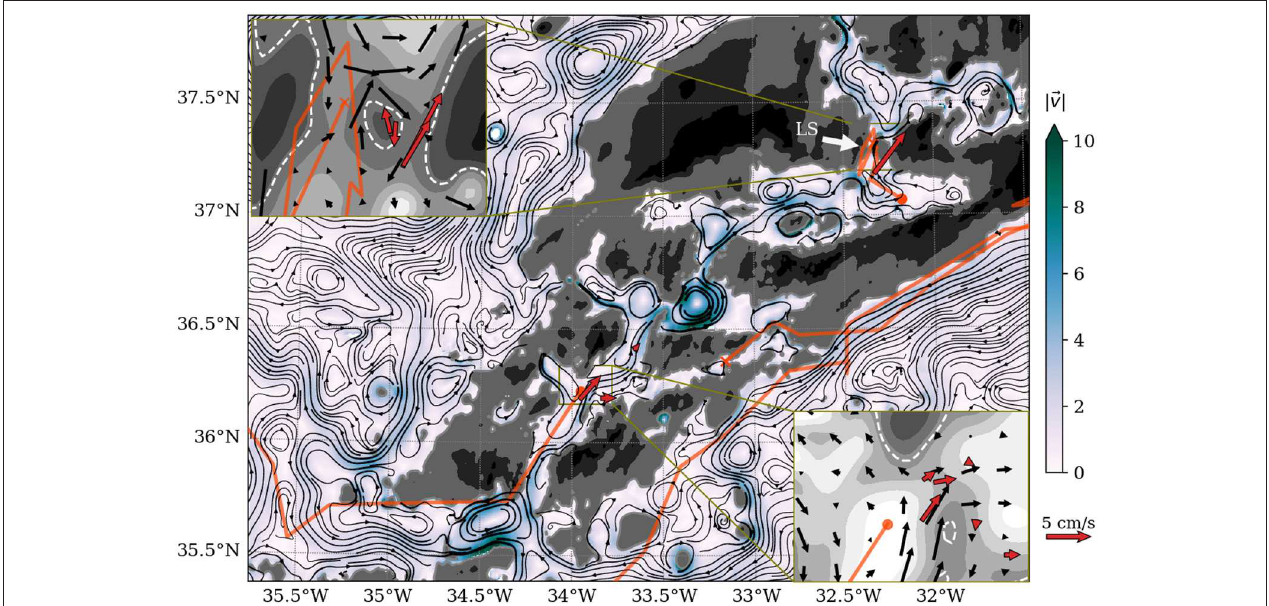
FIGURE 2 | Rift valley circulation at 2,000 m. The mean flow from numerical modeling is shown in black (“streamplot” with the line thickness proportional to the speed amplitude) and colors further indicate its magnitude. Superimposed are two ARGO float tracks near 1,990 m inside the rift valley and two other ones near 1,500 m flowing southward along the eastern flank of the ridge (orange, with the location of the release and last record indicated by a plain circle and a cross, respectively). Red arrows represent the mean velocity from selected moorings near the Rainbow vent field (2,100 m deep) and in the East canyon at Lucky Strike (1,875 m, LS label). Insets show zooms over these regions, representing the mean flow with black arrows. Black shading indicates bathymetry (using the same convention as in Figure 1 ) and white dashed contours in the insets indicate the depth at which the mean velocity is computed from the simulation (2,100 m at Rainbow, 1,800 m at Lucky-Strike, to match most of the available observations). At Rainbow, all 6 moorings available in the region are plotted. At Lucky-Strike, moorings are taken from (going west to east): Momar (1,700 m), DIVA (1,680 m), and Graviluck (1,930 and 1,874 m).